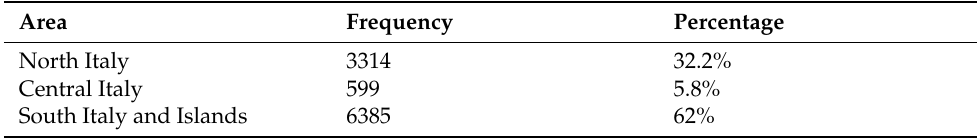
Table 1. Distribution of participants in the Italian geographical